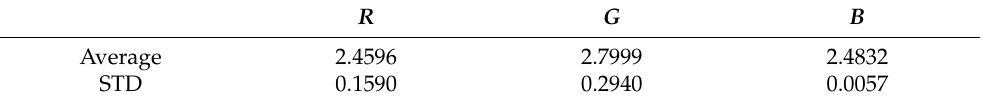
Table 4. Average and standard deviation values for the rgb image obtained by gaf transformation.